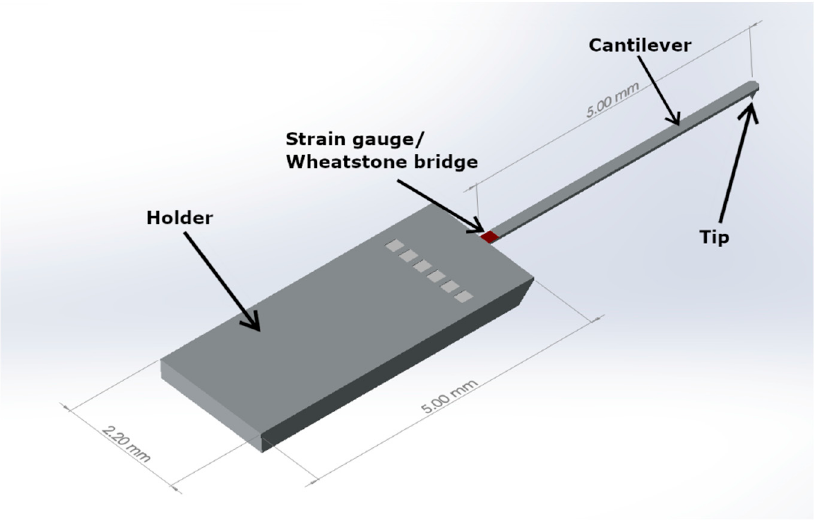
Figure 1. Illustration of a silicon microprobe.